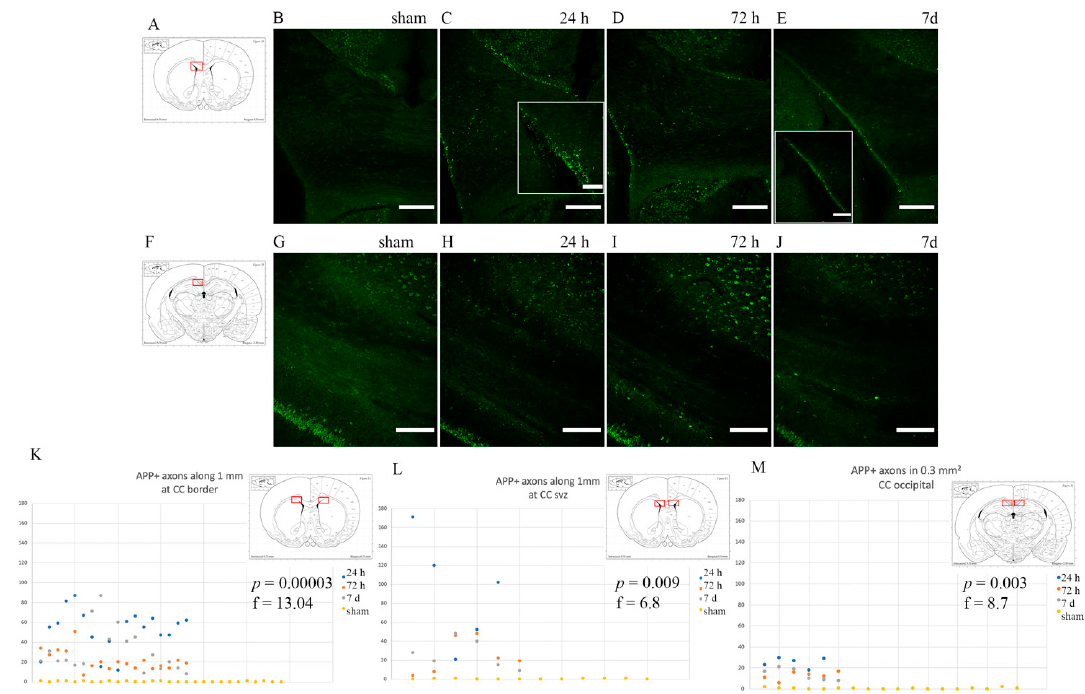
Figure 3. APP expression in the corpus callosum. Fluorescence microscopy photographs of the corpus callosum (coronal sections) at around 1mm from bregma (top row) and around − 3 mm from bregma (bottom row). ( A , F ) The highlighted area refers to the area represented in the photographs on the same row. ( C – E ) Following injury, axonal bulbs localize mostly at the borders between the corpus callosum and grey matter. Insert show details of the CC-lateral ventricle border area. ( H – J , M ) Moving occipitally, APP expression is comparatively less. ( B , G ) Sham animals do not show APP accumulation in the axonal terminals at the regions of interest. ( K – M ) Scatter plots showing the amount of APP + profiles in each ROI (y-axis represents the number of APP + profiles; x-axis represents each observation). APP expression is maximal at 24 h and decreases thereafter, with p ≤ 0.05 at one-way ANOVA analysis. Scale bar = 300 μ m (top row); scale bar = 500 μ m (bottom row); scale bar = 150 μ m (C insert); scale bar = 500 μ m (E insert).